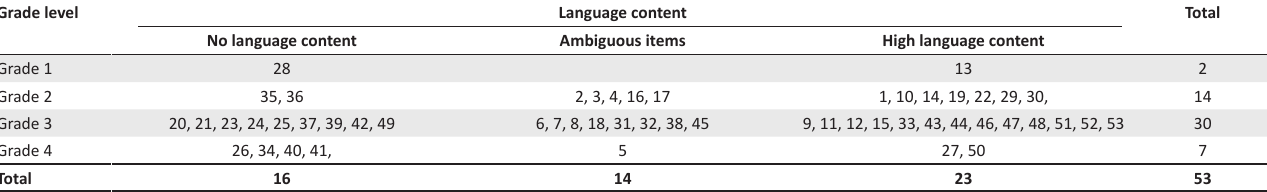
TABLE 6: Distribution of items in Test 1 and Test 2 grade 3 numeracy test by grade-level and language